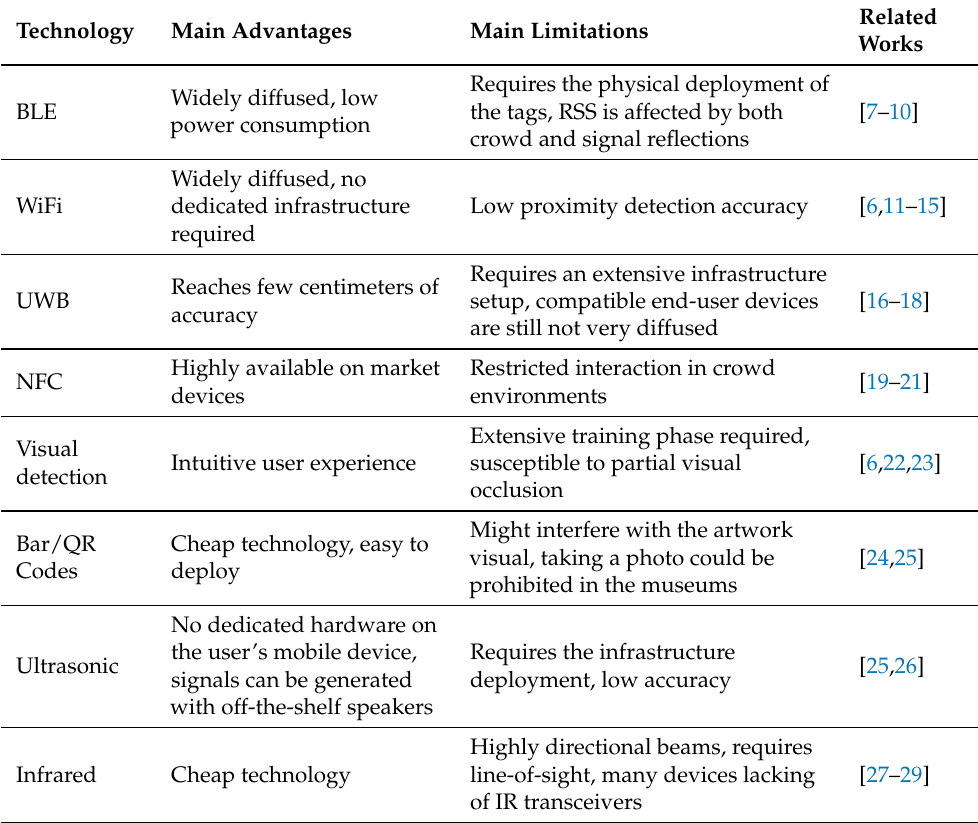
Table 1. Summary of the main proximity detection technologies used in the